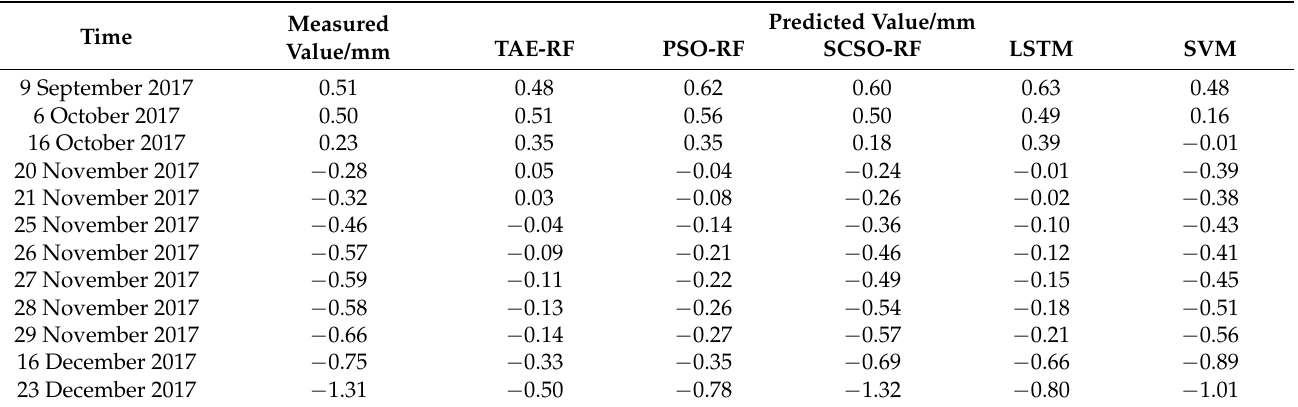
Table 4. Predicted values of models at the specified points.